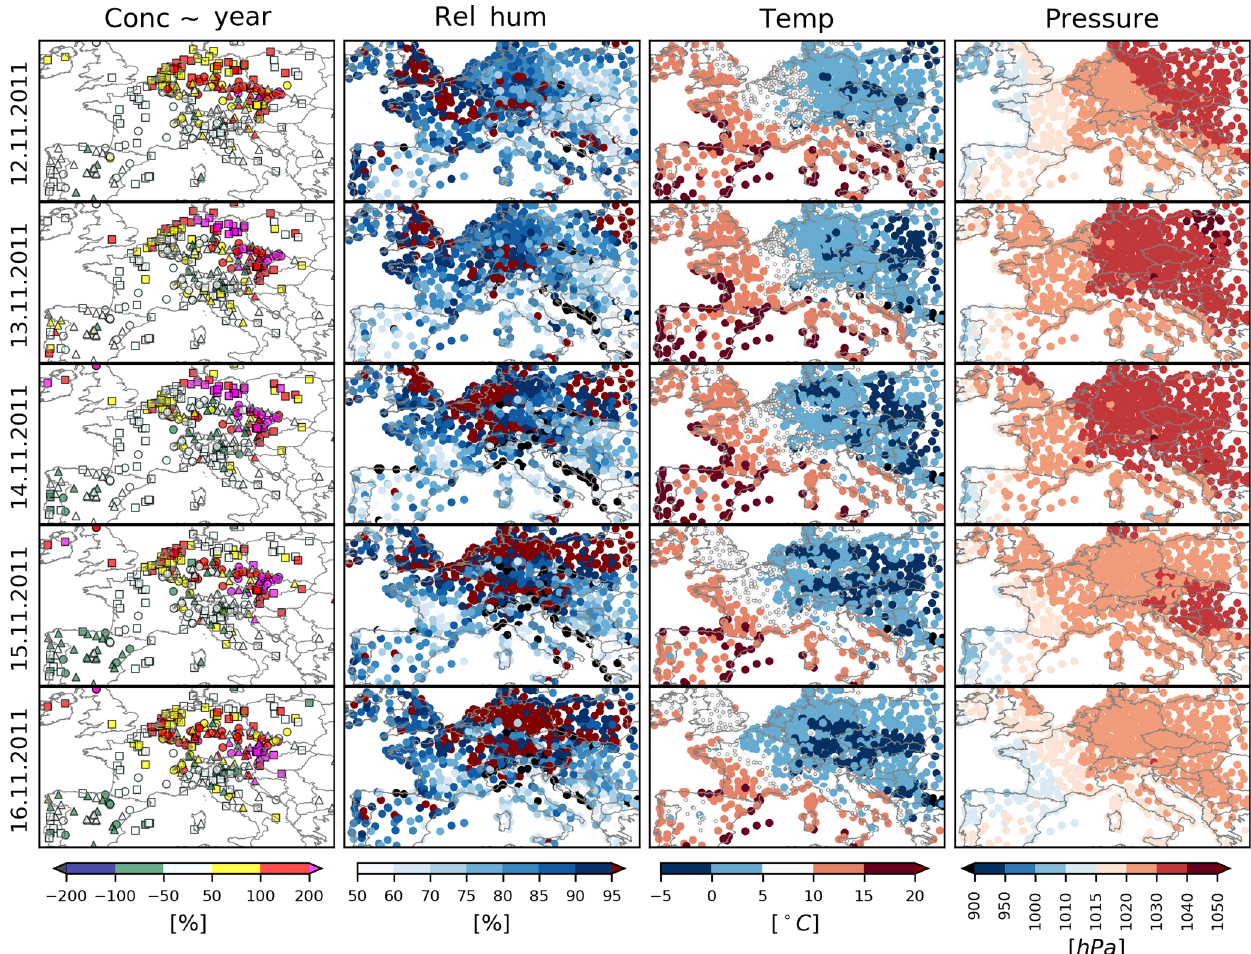
Figure 4. Same as Fig. 3, but during the second large-scale episode (12 to 16 November).